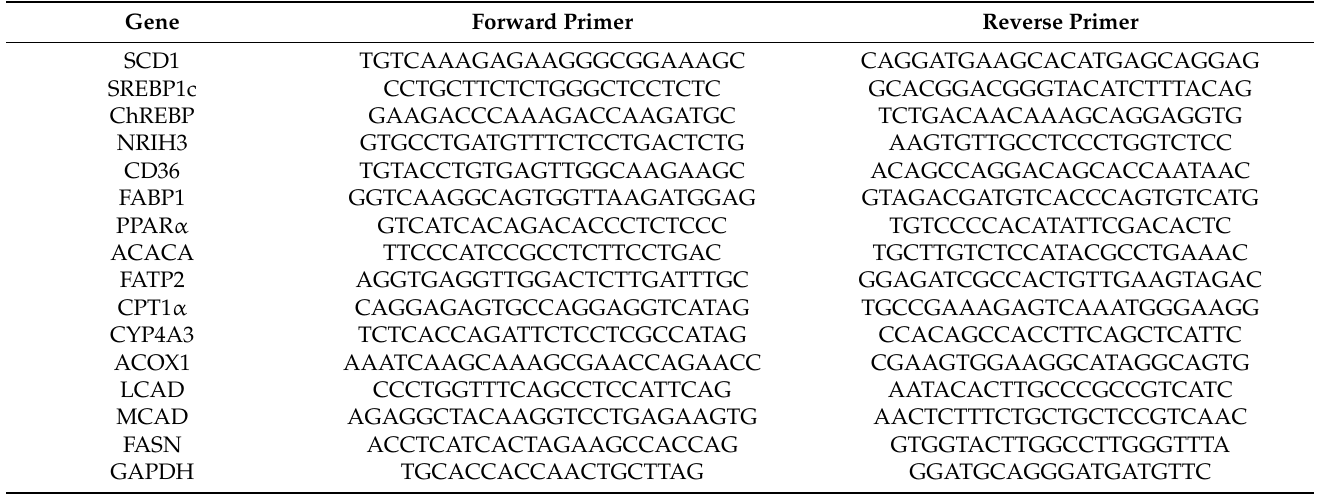
Table 1. Primers for